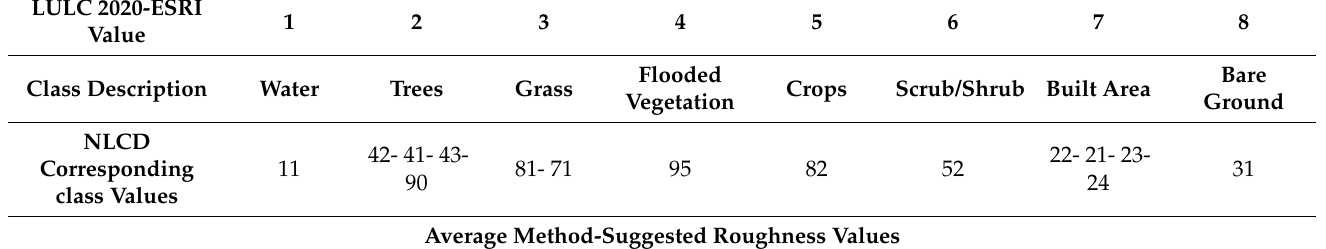
Table 5. LULC 2020-ESRI proposed roughness values using average and weighted average meth- ods.